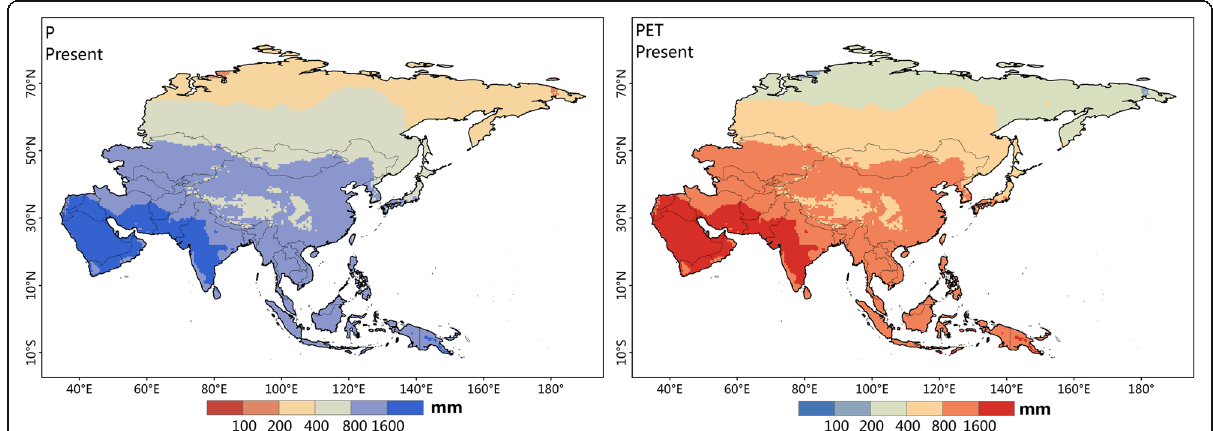
Fig. 1 Annual precipitation and PET across Asia for the present period. Annual precipitation (left) and PET (right) across Asia for the present period (1985 – 2005) based on CRU observational data